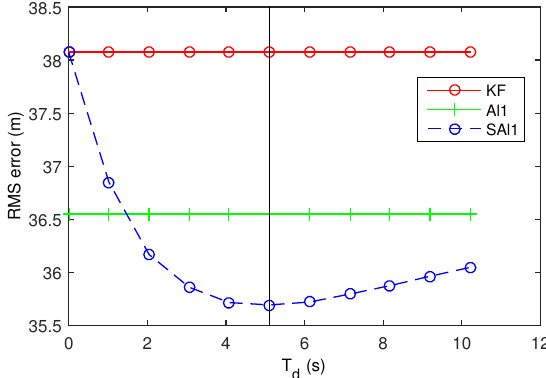
Figure 8. Performance of selective out-of-sequence filters for Arrowhead